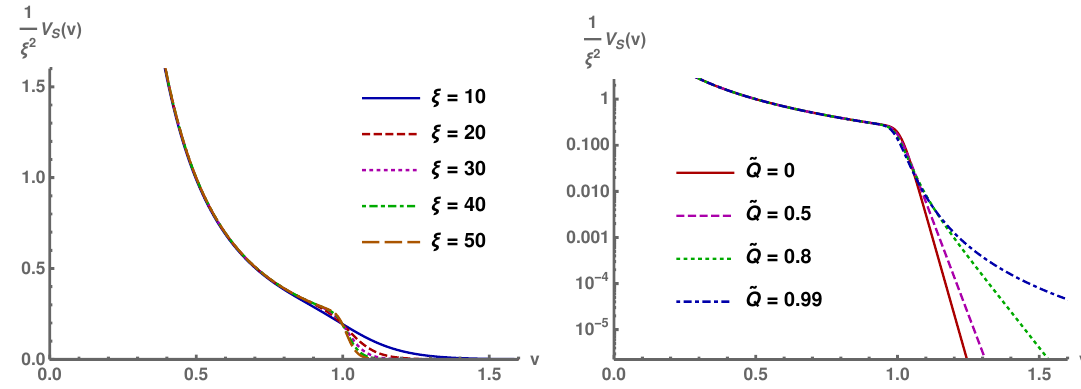
Figure 1 . Left: the dependence of the Schrödinger potential of the helicity-two fluctuations on ξ at zero charge and momentum. Right: the dependence of the potential on charge at zero momentum and at ξ = 50